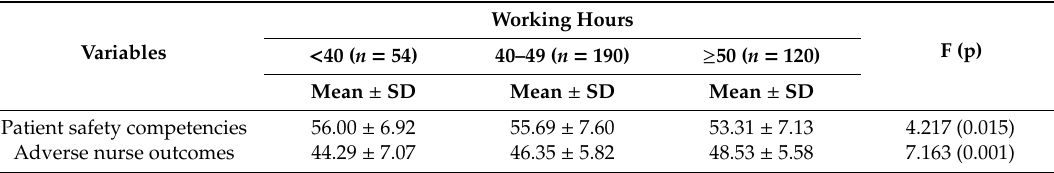
Table 2. Di ff erences in patient safety competencies and adverse nurse outcomes by working hour group ( N =